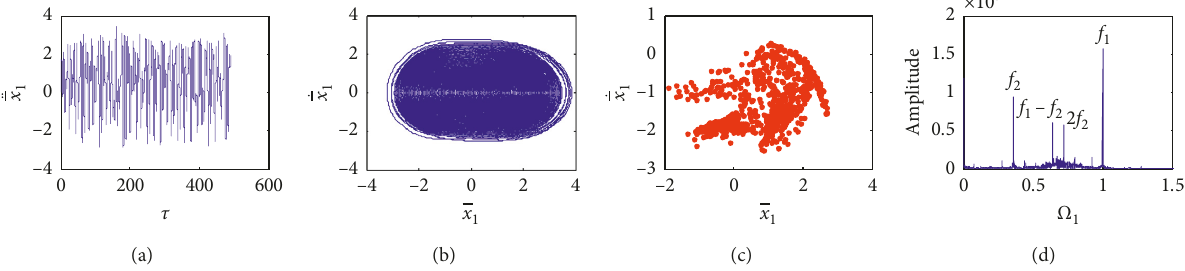
Figure 6: Vibration characteristics when Ω � 1: (a) time domain, (b) phase diagram, (c) Poincar´e section, and (d) frequency 1